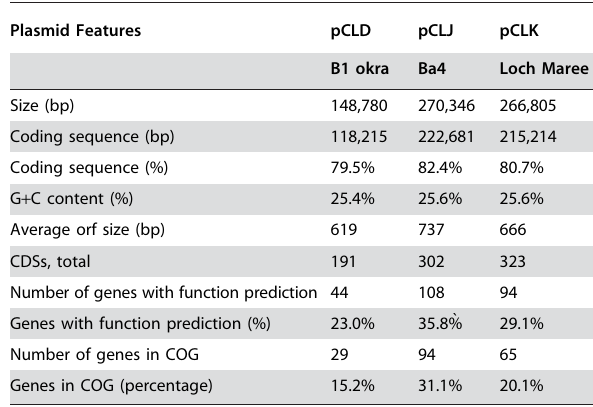
Table 3. Plasmid features of pCLD, pCLJ and pCLK. .. ... .... ... ... .... ... ... .... ... ... .... ... ... .... ... ... .... ... ... .... .